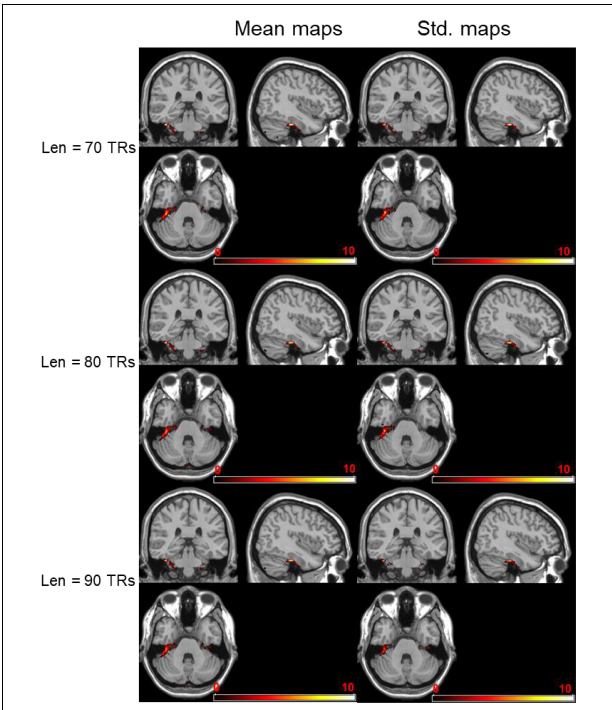
FIGURE 5 | Positively activation brain regions regarding dynamic brain entropy maps (seafarers’ entropy value > non-seafarers’ entropy value; AlphaSim correction, p < 0.05).